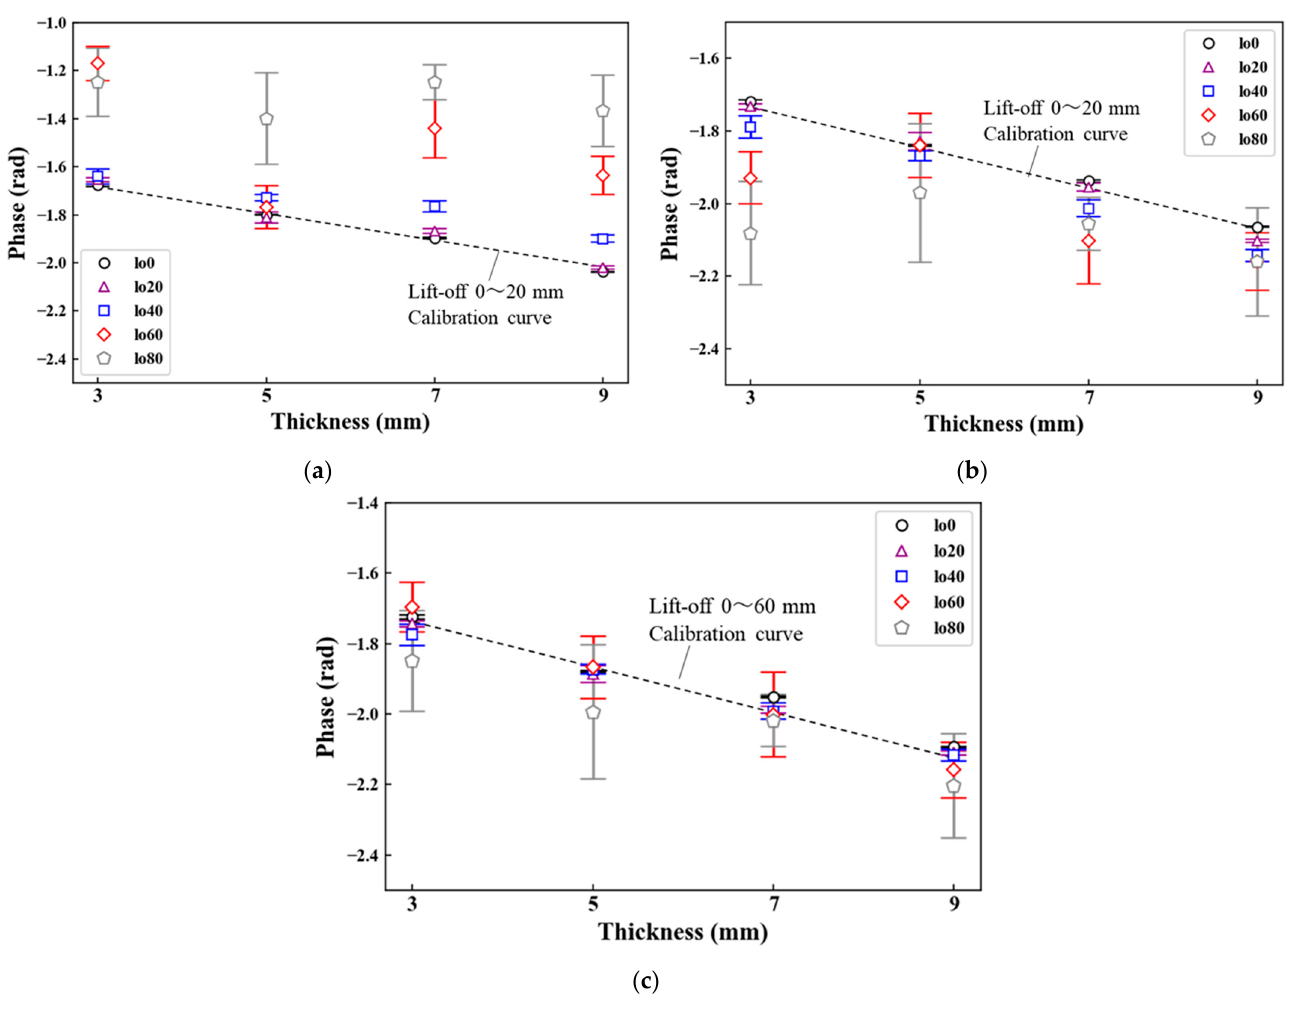
Figure 9. Plate thickness-phase characteristics (coil area: ( a ) 50 mm 2 , ( b ) 70 mm 2 , ( c ) 100 mm 2 ).